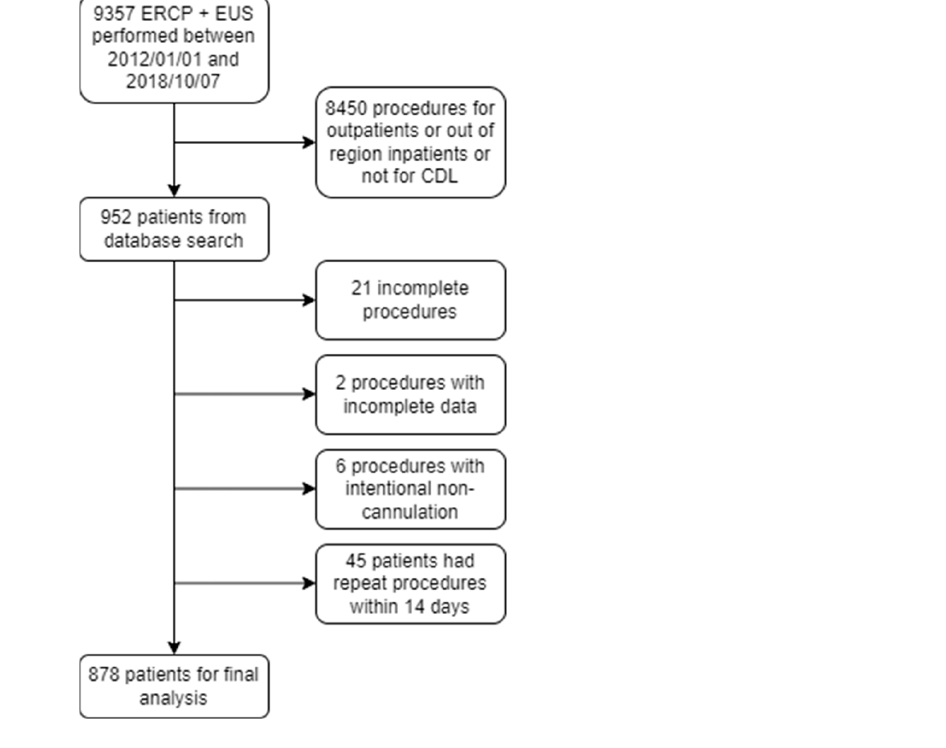
Figure 1. Patient selection flow diagram (CDL, choledocholithiasis; EUS, endoscopic ultrasound; ERCP, endoscopic retrograde cholangiopancreatography). Table 2. Baseline patient, procedure, biochemical, and imaging parameters of the 879 patients analyzed as part of the study